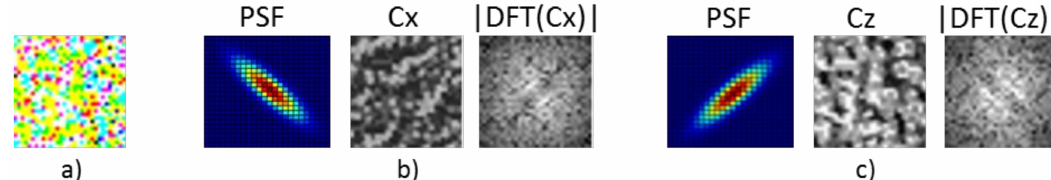
Figure 2. ( a ) Watermarked CMY halftone block; ( b ) PSF used for embedding the oriented feature in the red-green Cx channel, shown in spatial and frequency domain; ( c ) Same as ( b ) but for the blue-yellow channel